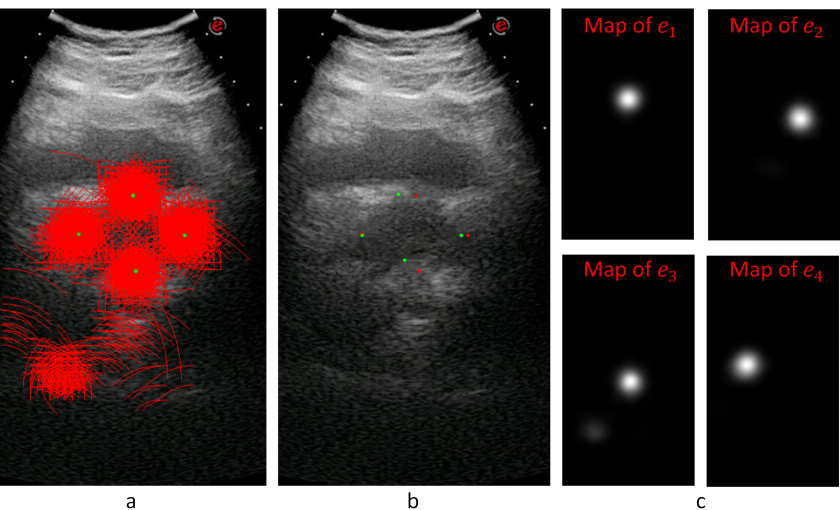
Figure 8. For a given transverse image, ( a ) shows the voting arcs (without thickness); ( b ) shows the detected points (reds are expert marked locations, while greens are the detected locations of the diameter end points); and ( c ) shows the voting maps for e 1 , e 2 , e 3 , and e 4 endpoints.